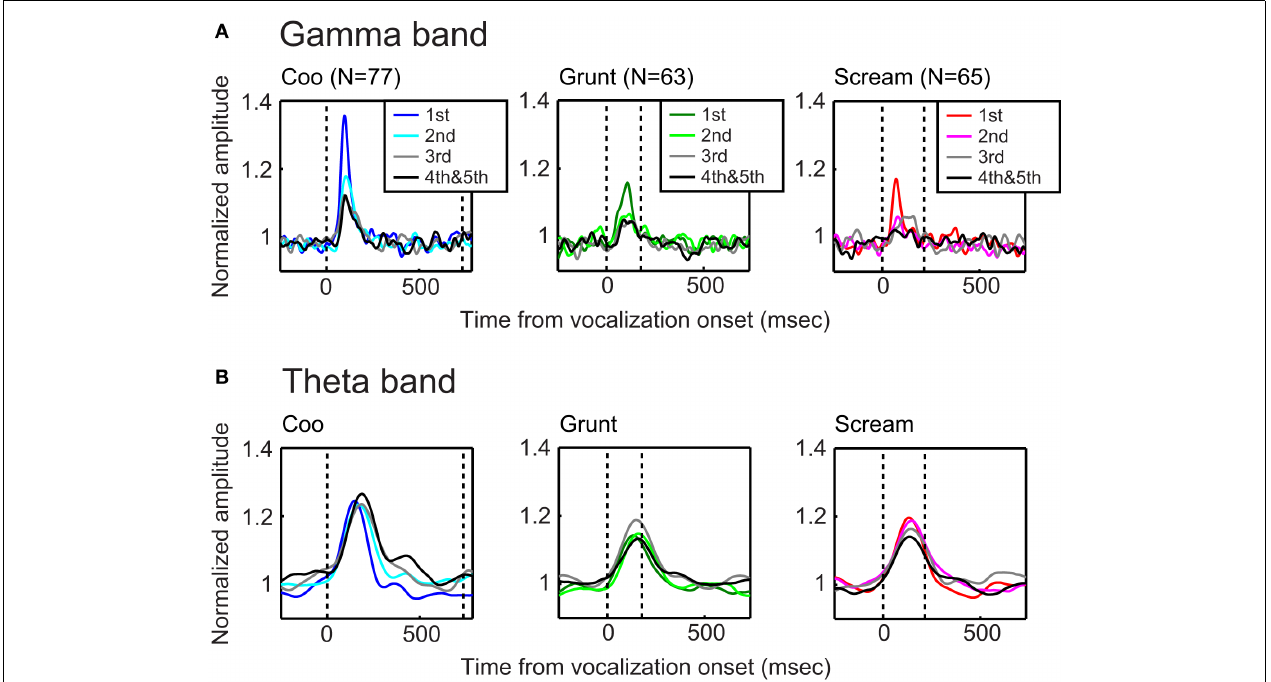
different vocalization: coo (left; n = 77 sites), grunt (middle; n = 63 sites), and scream (right; n = 65 sites).The presentation format is same as Figure 4A .The data in each column of (B) illustrate the effect that repeated presentations of a vocalization had on the normalized amplitude of the theta